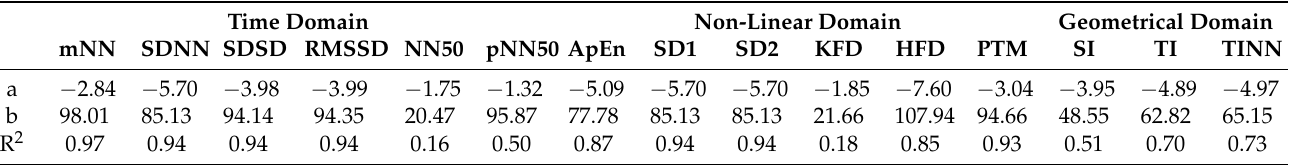
Table A1. Wilcoxon Rank Sum Test — Linear Regressions of the Statistical Percentages.